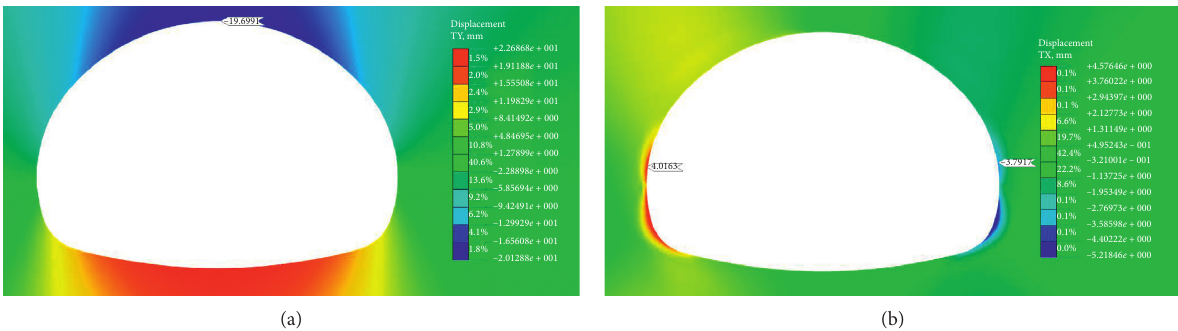
Figure 6: Simulated results of tunnel portal section. (a) Crown settlement. (b) Horizontal